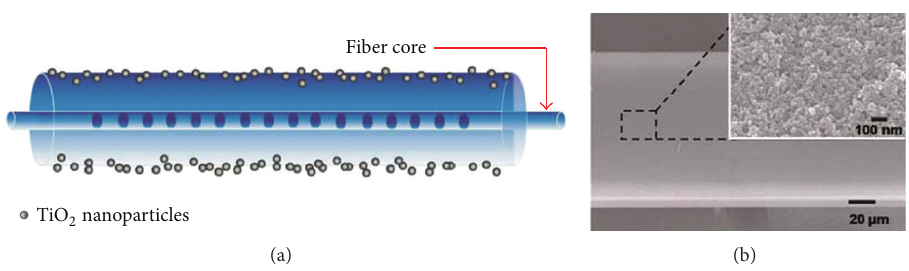
Figure 15: Glucose measurement using a LPFG coated with TiO 2 nanoparticles (taken from